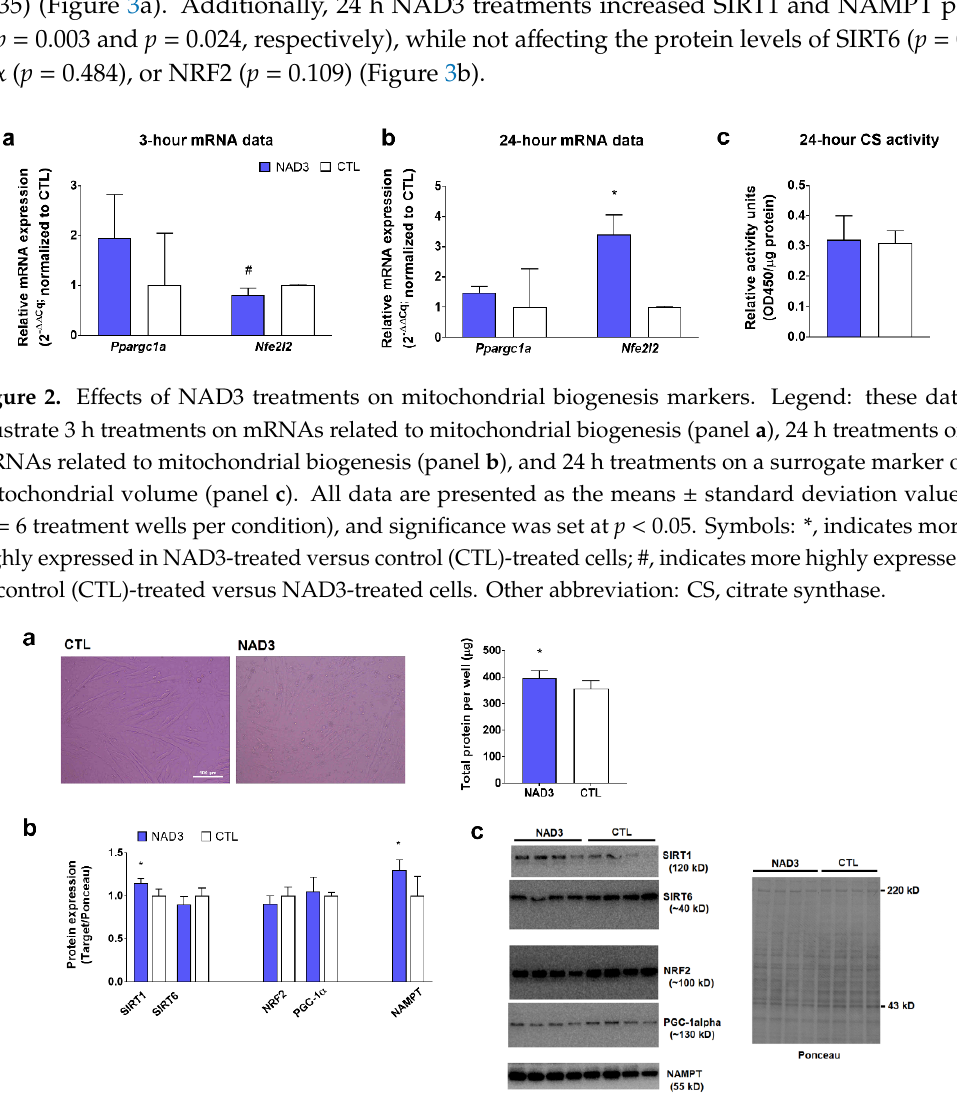
Figure 3. Effects of NAD3 treatments on select protein targets. Legend: these data illustrate 24 h NAD3 treatments that do not affect cellular morphology, while also increasing protein levels per well (a surrogate of cellular health) (panel a ). Twenty-four hour NAD3 treatments also increased SIRT1 and NAMPT protein levels, while not affecting other protein targets (panel b ). Panel c also illustrates representative Western blots of each assayed target. All data are presented as the means ± standard deviation values ( n = 5–6 treatment wells per condition), and significance was set at p < 0.05. Symbols: *, indicates more highly expressed in NAD3-treated versus control (CTL)-treated cells.